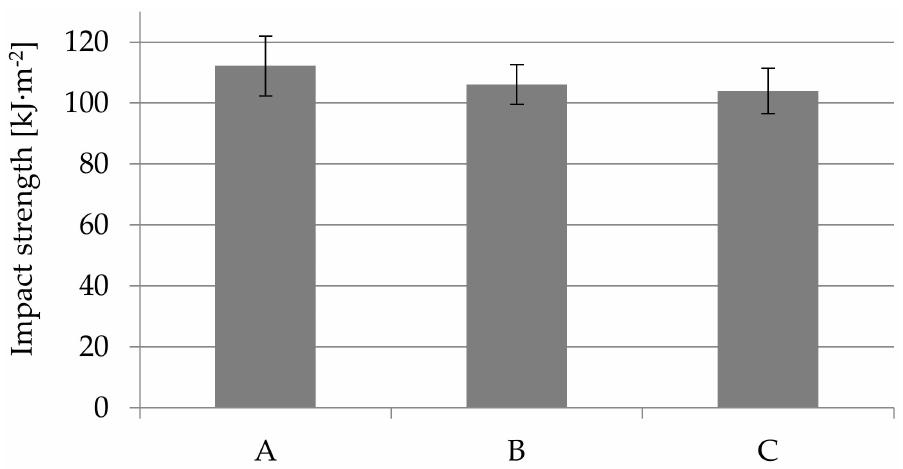
Figure 15. Influence of nitrogen pressure on the impact strength for unnotched thick-walled PA66 GF30 moldings with a thickness of 6 mm, where A is a solid sample, while B and C are foamed at 16 and 20 MPa nitrogen pressure respectively.